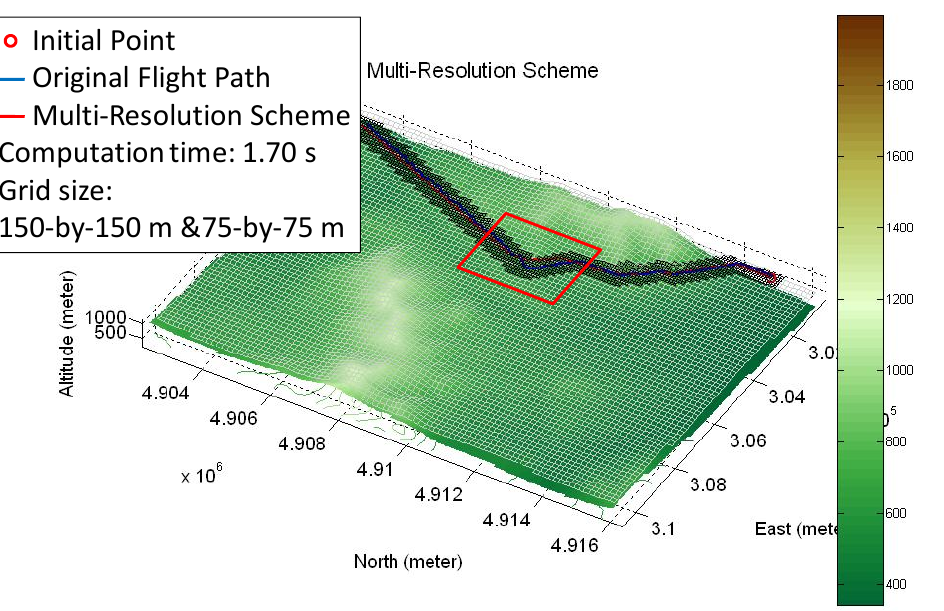
Figure 7. The flight path is planned by using the FPPS with the Multi-Resolution